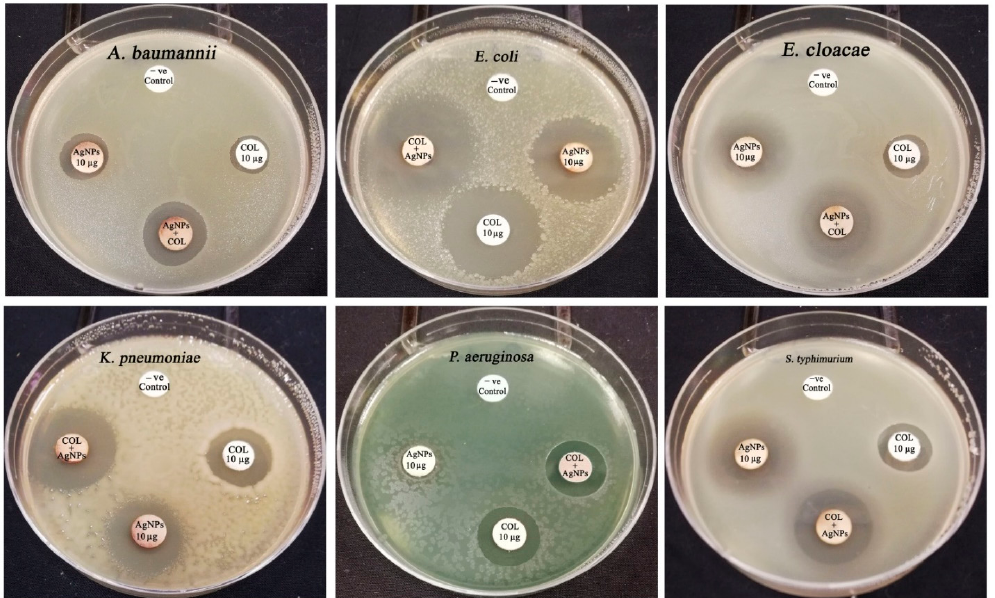
Figure 11. Synergistic antimicrobial efficacy of colistin antibiotic with the biosynthesized AgNPs against the concerned bacterial pathogens. Table 3. Synergistic antibacterial activity of the biogenic AgNPs with colistin antibiotic against the tested strains.